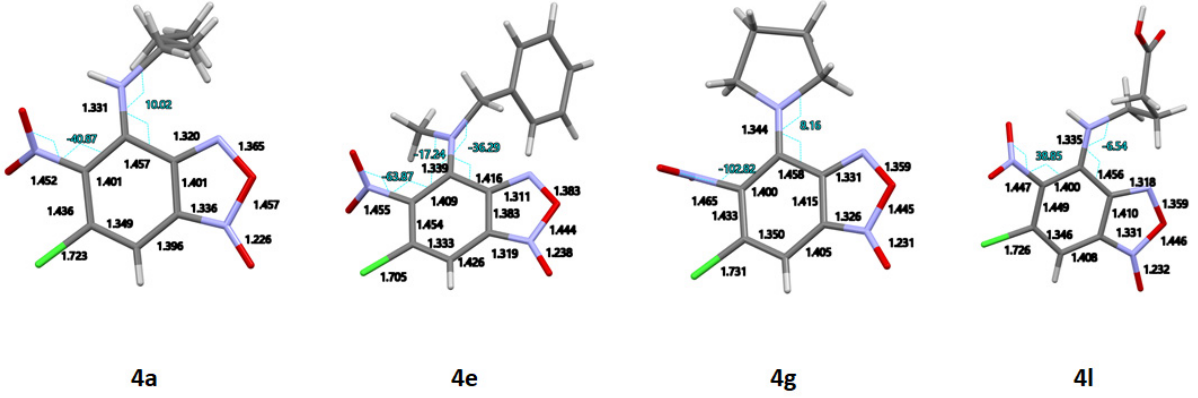
Figure 7. Geometry of 4a , 4e , 4g , and 4l .